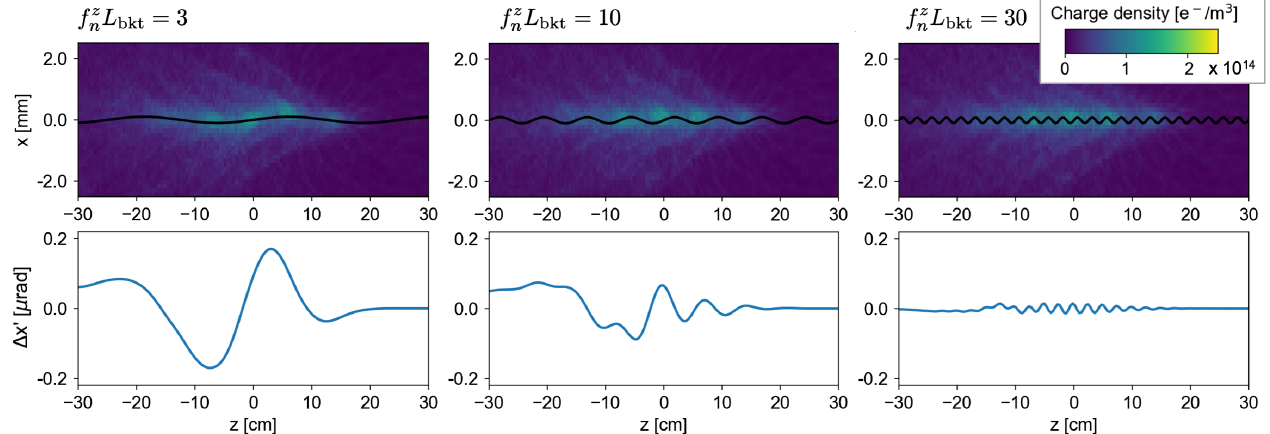
FIG. 3. Top: some of the applied test functions (in black) and corresponding evolution of the electron density. Bottom: dipolar kick measured along the bunch as an effect of the applied test function (the effect of the e-cloud quadrupolar forces is already